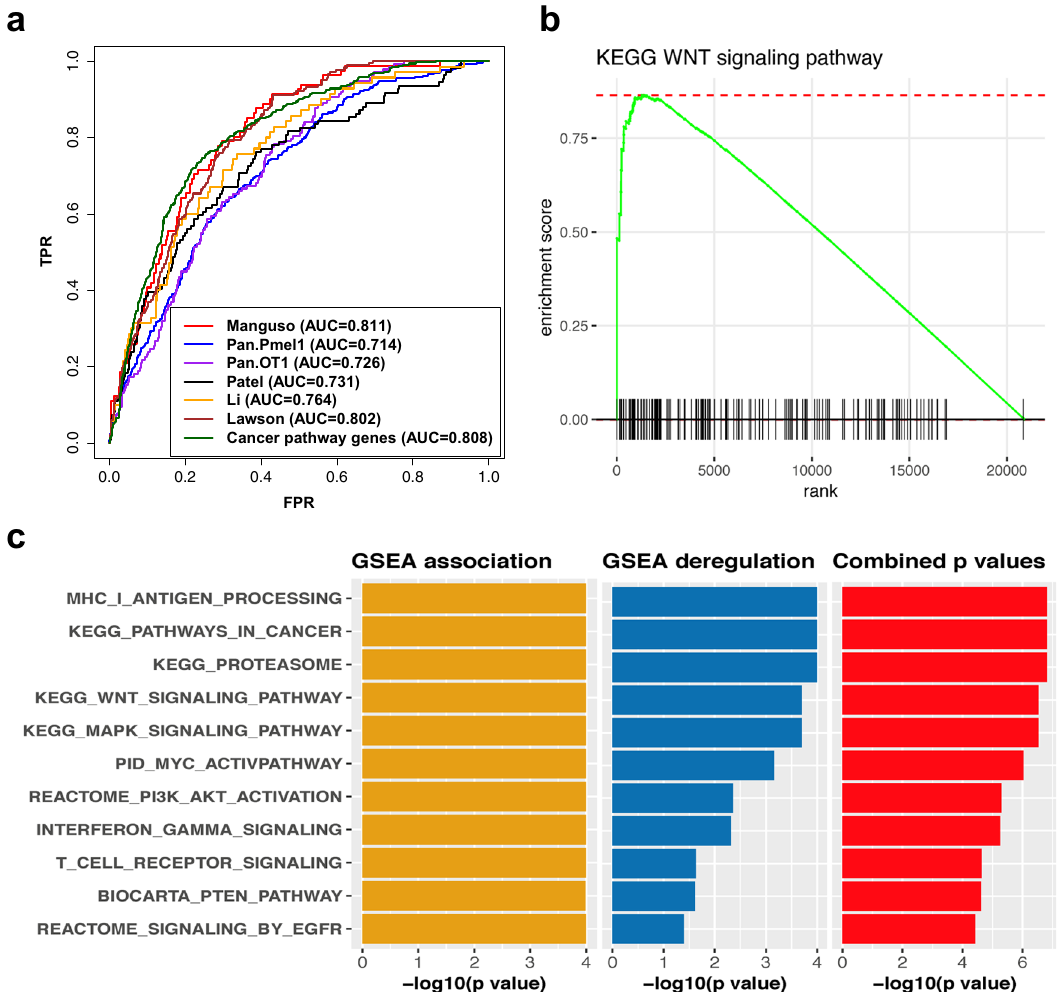
Fig. 2 Evaluation of the MHC I-association prediction using benchmark gene sets and known pathways associated with anti-PD-1 therapy. a Receiver operating characteristic (ROC) curves for 6 CRISPR-based gene sets and a set of cancer pathway genes: 81 genes from Manguso (Manguso), 289 genes identi fi ed with Pmel-1 T cells from Pan (Pan_Pmel1), 138 genes identi fi ed with OT-1 T cells from Pan (Pan_OT1), 109 genes from Patel (Patel), 74 genes from Li (Li), 182 genes from Lawson (Lawson), and 328 genes from the Kyoto Encyclopedia of Genes and Genomes (KEGG) cancer pathways (cancer pathway genes). Genes in these seven gene sets were treated as positive instances, and the remaining genes in the gene network were treated as negative instances. TPR true positive rate, FPR false-positive rate, AUC area under the ROC curve. b GSEA association plot of the Wnt pathway from our prediction. GSEA evaluated the genes of the pathway for their distribution in the ordered gene list generated by our association prediction. c Some pathways that were signi fi cantly associated with the MHC I pathway in our prediction. The length of a bar represents the magnitude of the statistical signi fi cance (shown as − log10 value of p -value) of a given pathway in GSEA association analysis, GSEA deregulation analysis, or combination analysis using the truncated product method. The source data of all the panels in this fi gure are provided in the Source Data fi